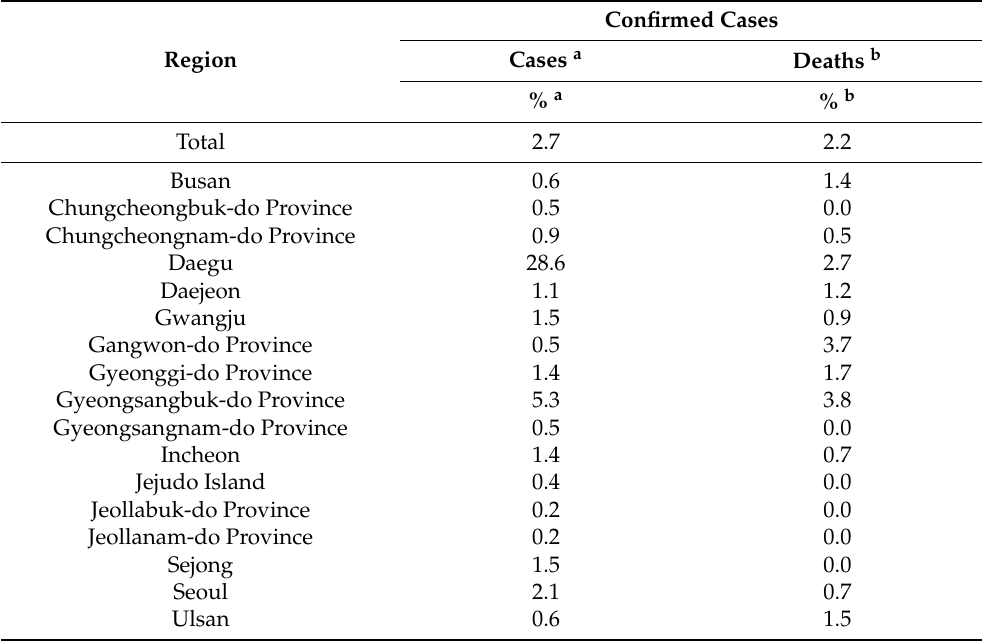
Table 1. The total number of confirmed cases as of 16 August 2020 as well as case and fatality rates by region.